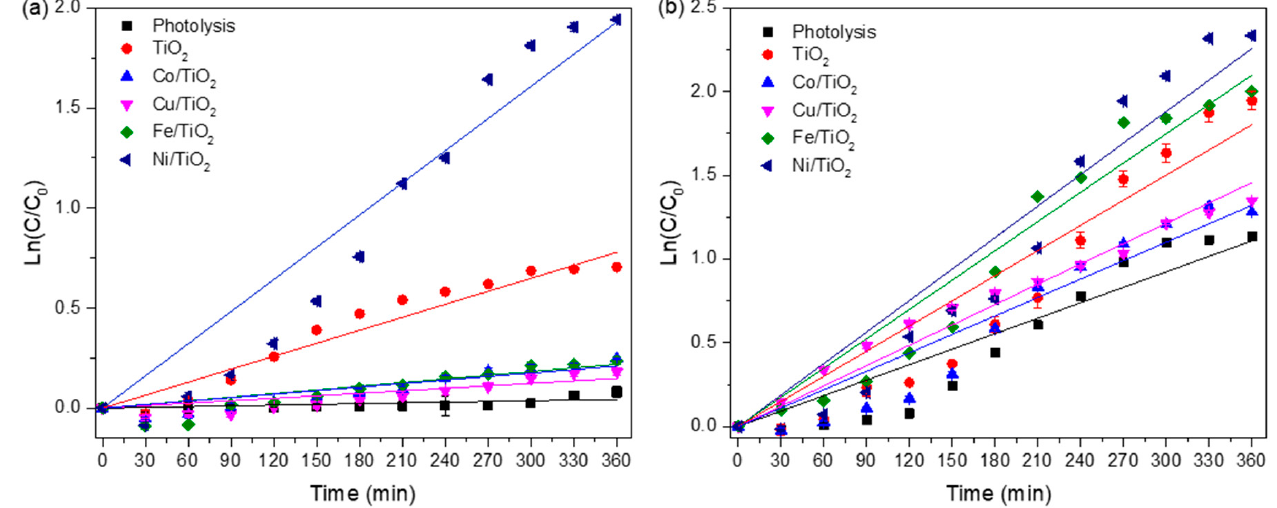
Figure 14. Experimental data and fitting assuming a pseudo-first order reaction rate: 2,4-D ( a ) and 2,4-DCP ( b ). 2,4-DCP ( b ).